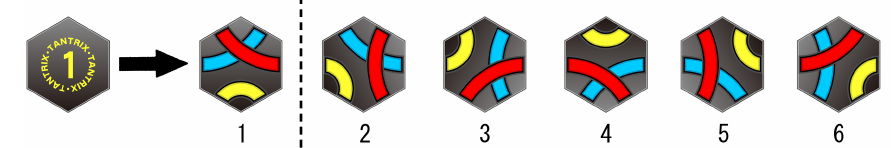
Figure 8. Orientations of a